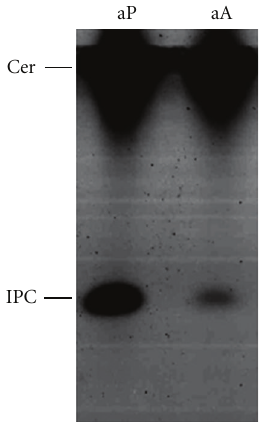
Figure 2: HPTLC analysis of axenic procyclic promastigotes (aP) and amastigotes (aA) metabolically labelled with BODIPY FL C 5 - ceramide. IPC: inositol phosphorylceramide; Cer: ceramide.